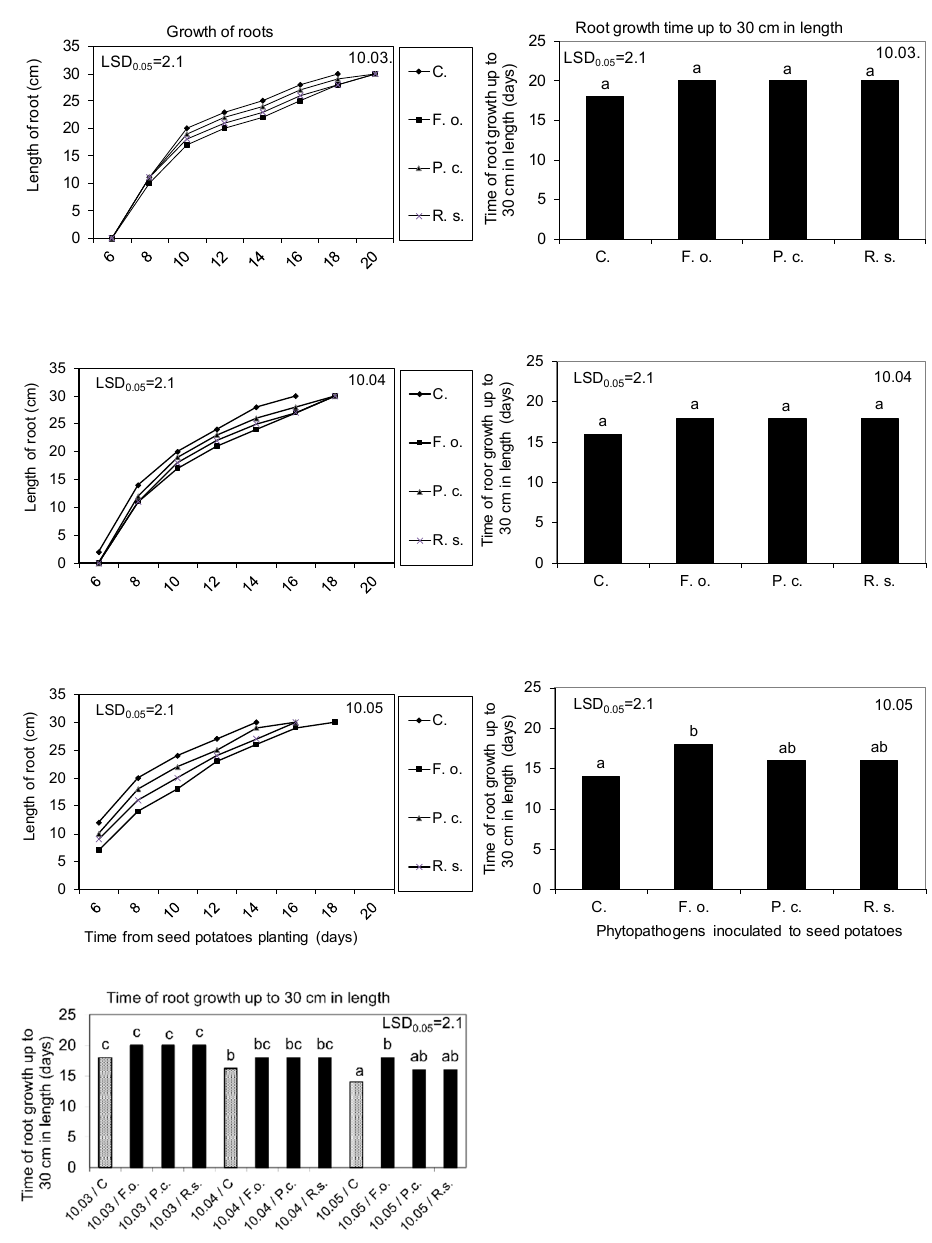
Figure 6. Kinetics of root growth and time of its growth up to 30 cm in length, as affected by the seed potatoes storage at 4 °C from harvest until inoculation with phytopathogens on 10 February and then at 15 °C and 80% RH before planting in the soil on 10 March, 10 April, and 10 May. C—Control, Fo— F. oxysporum , Pc— P. corotovorum , Rs— R. solani . Means marked with the same letters do not differ statistically at the significance level p = 0.05. LSD was calculated at the significance level of p = 0.05.